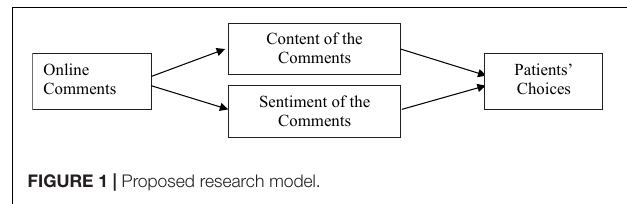
FIGURE 1 | Proposed research